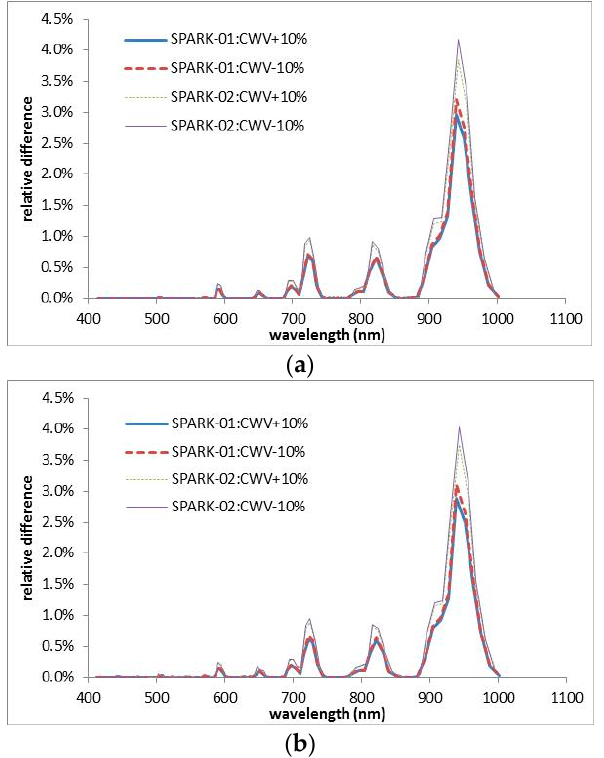
Figure 26. Calibration uncertainties caused by the water vapor content measurements for SPARK-01 and -02 using the ( a ) reflectance- and ( b ) irradiance- based (or improved irradiance-based) methods, respectively.